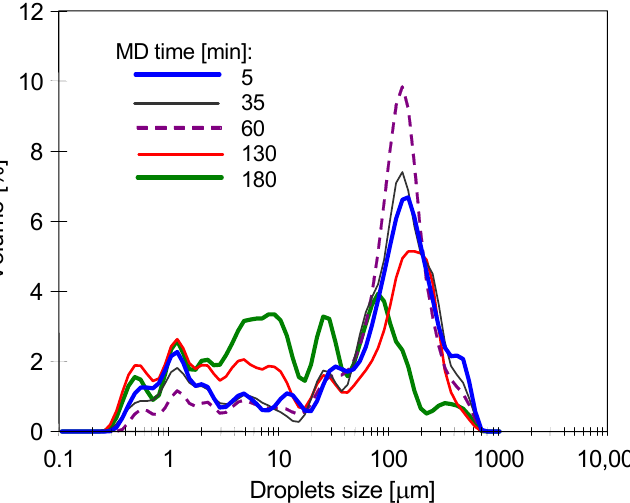
Figure 5. Changes in the droplet size distribution during the MD process. Feed: Baltic Sea water + oil (85 mg/L) + SDS (1.5 mg/L). Module CMD.